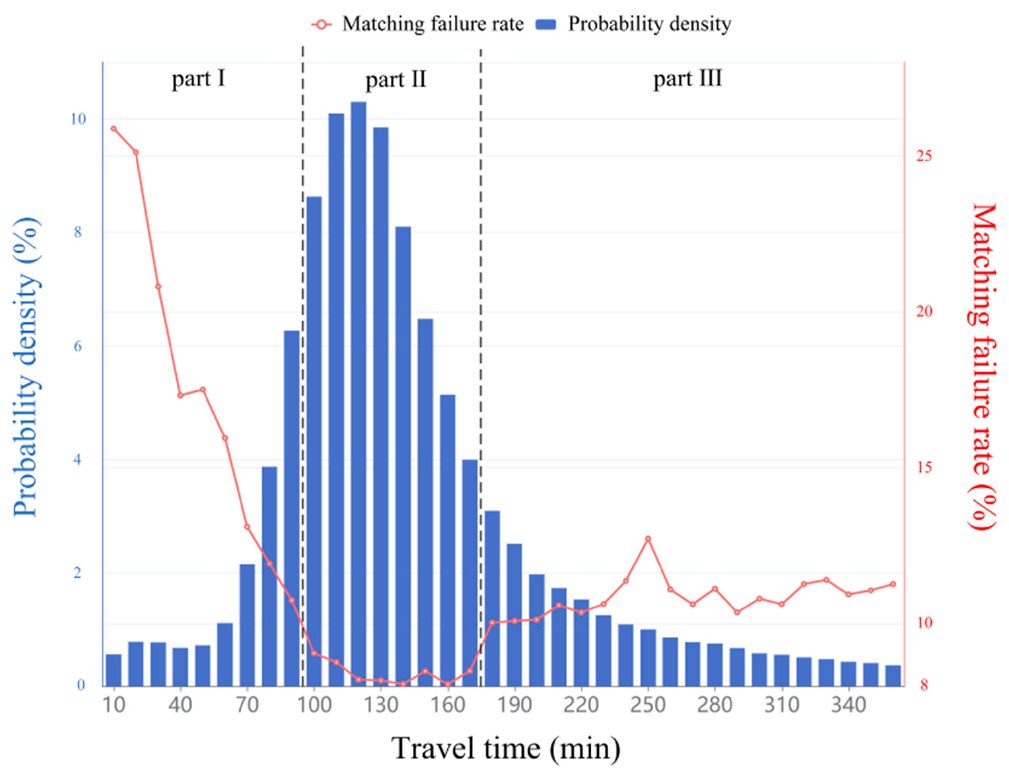
Figure 7. Distribution of intercity ridesplitting travel times.